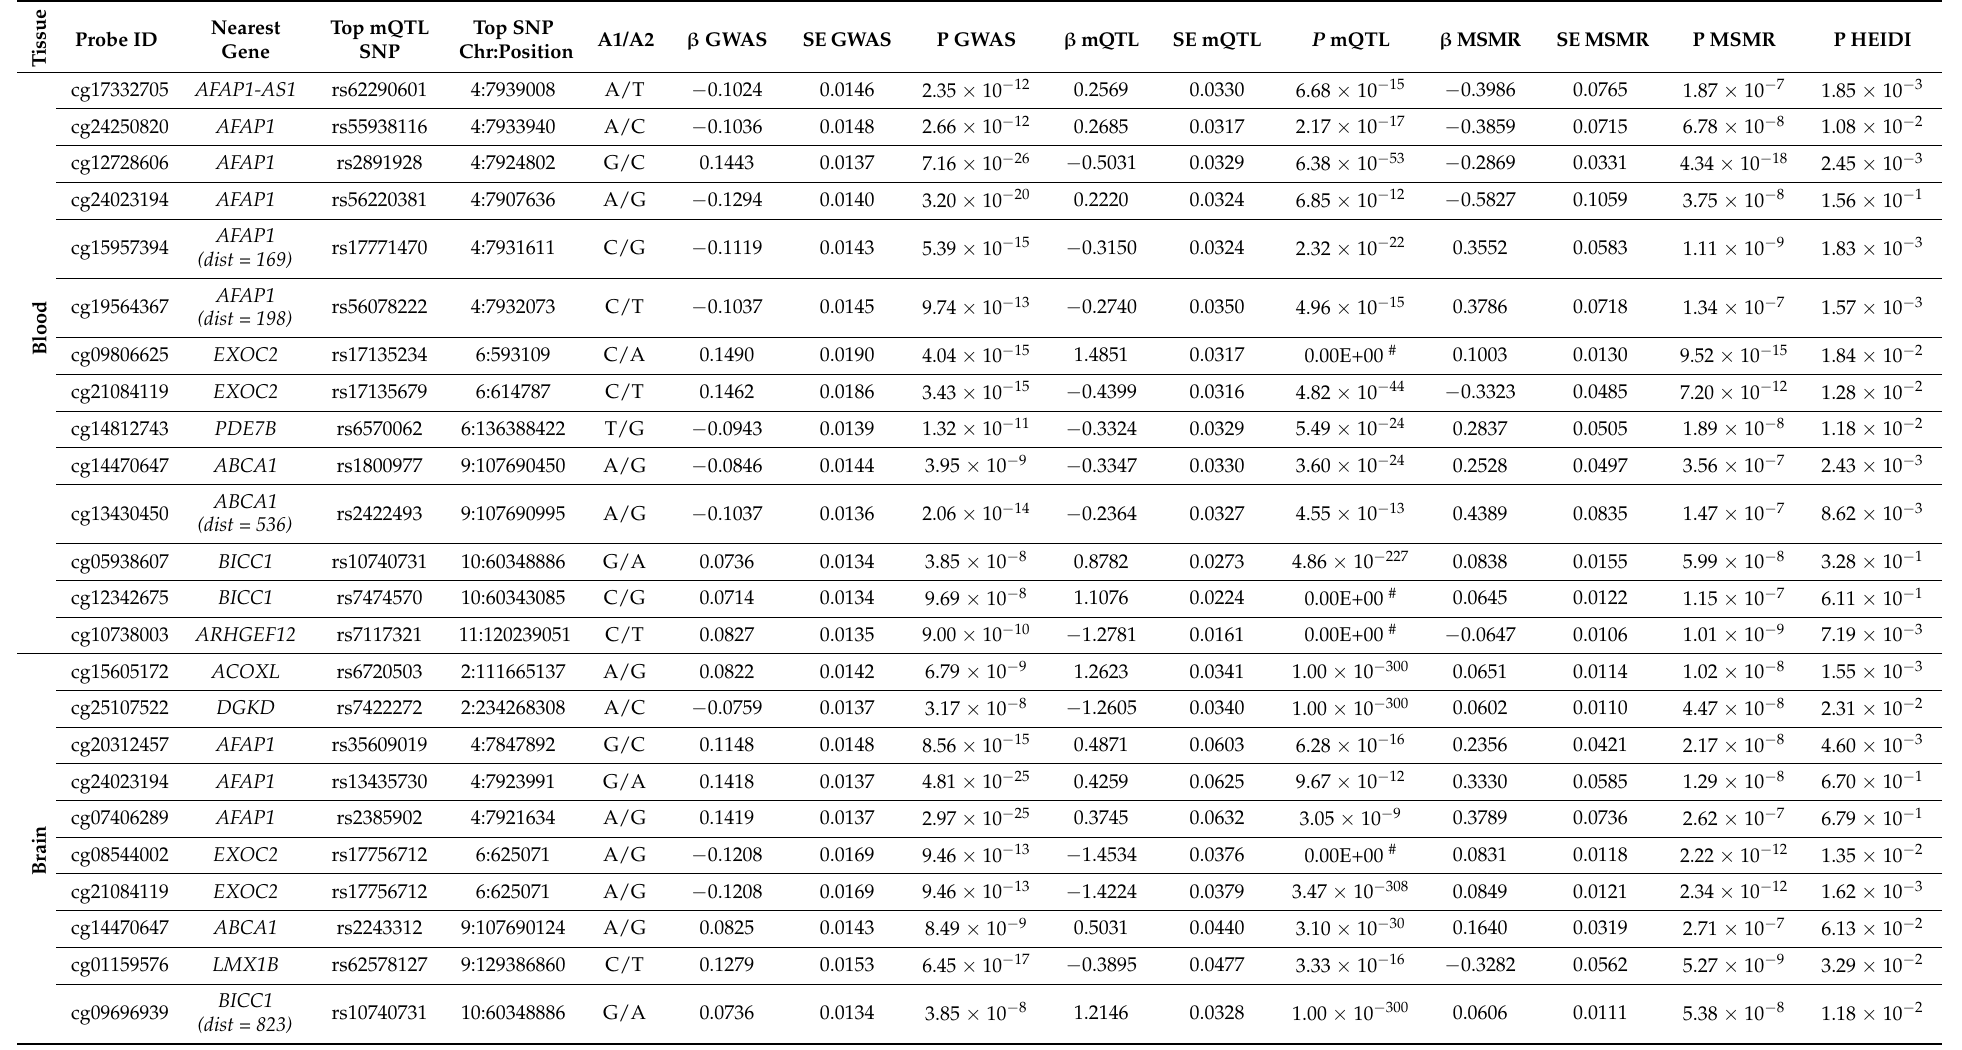
Table 5. Significant MSMR results of POAG GWAS using dataset of whole blood [36] and brain mQTLs